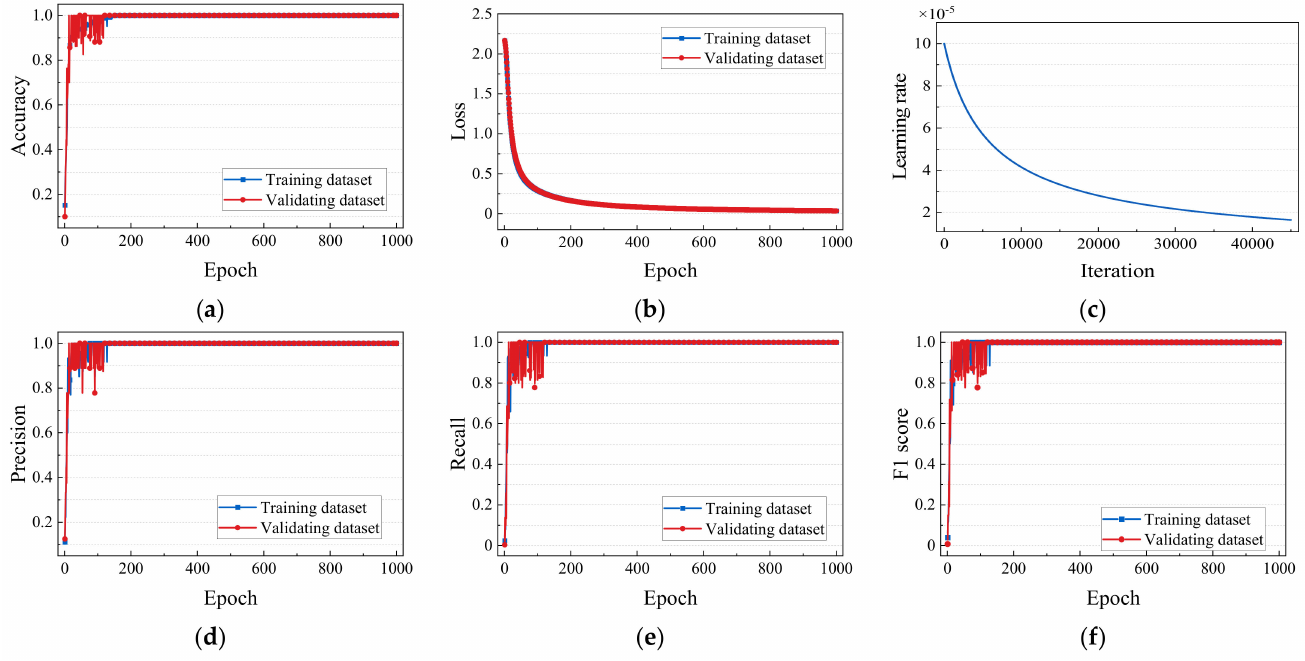
Figure 13. The training process of time − frequency diagram: ( a ) accuracy of training process; ( b ) loss of training process; ( c ) learning rate of training process; ( d ) precision of training process; ( e ) recall of training process; ( f ) F1 score of training process.